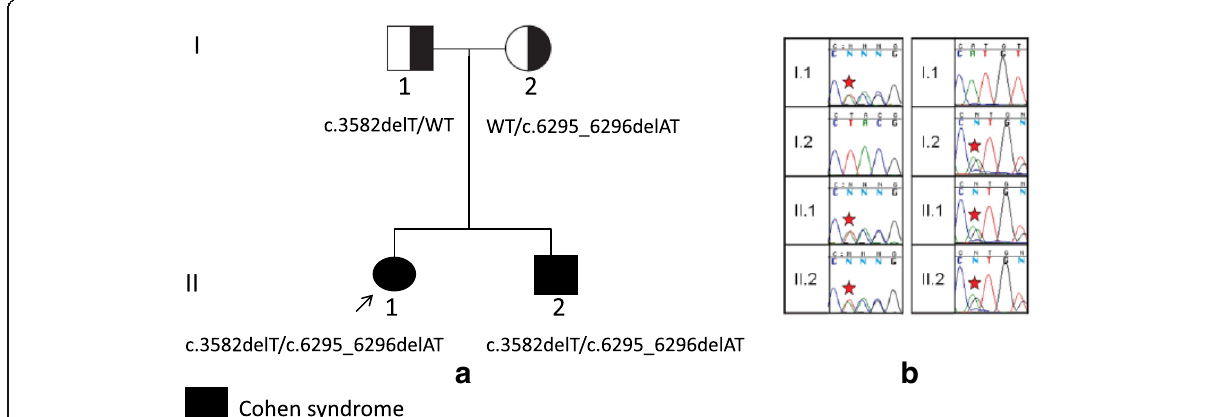
Fig. 3 a Pedigree of the Tunisian family and compound heterozygosity of the proband, formed by the c.3582delT mutation, inherited from the father of the proband and also present in her brother, and the c.6295_6296delAT mutation inherited from the mother. The 2 mutations are shown in black, and in white the wild type alleles (WT). b Sanger validation shows segregation of the VPS13B mutations in the four family